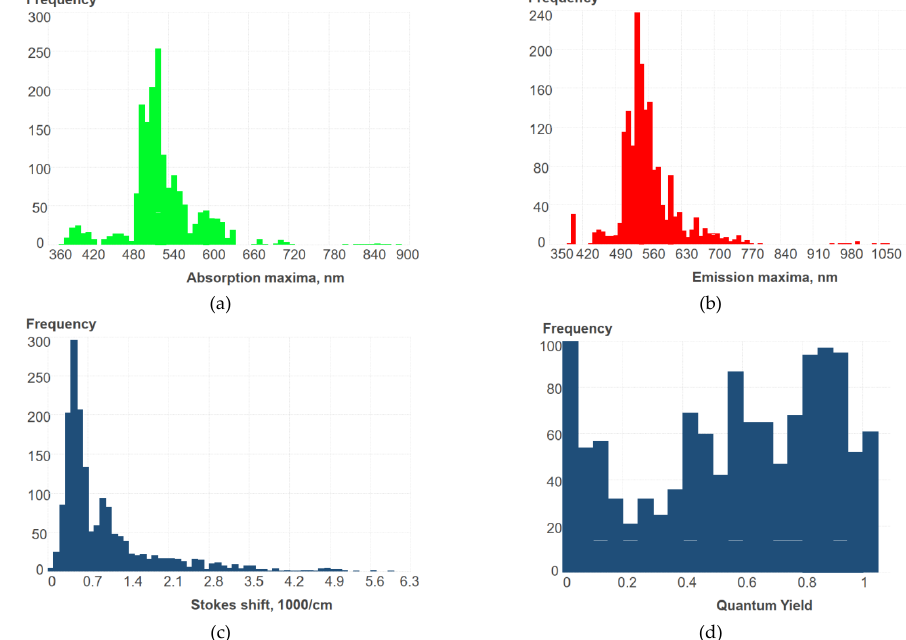
Figure 1. Frequency diagrams for a dataset of 115 BODIPYs: ( a ) absorption maxima; ( b ) emission maxima; ( c ) Stokes shift; ( d ) fluorescence quantum yield.